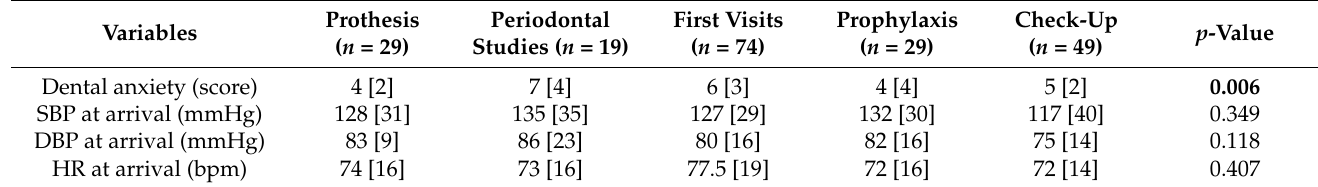
Table 6. Comparisons of study variables by type of treatment (Median [IQR]).